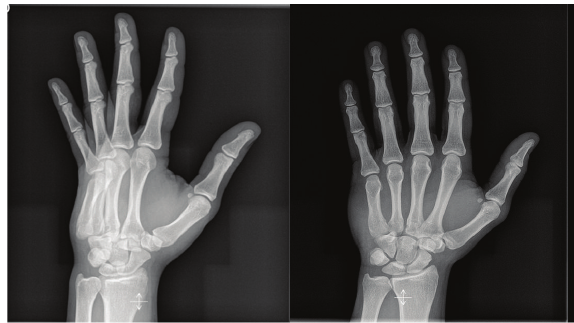
Figure 1: X-Ray: oblique and anteroposterior view of the hand. Oblique view shows a complete dislocation of the fourth and fifth CMC joints and a partial dislocation of the third CMC joint.